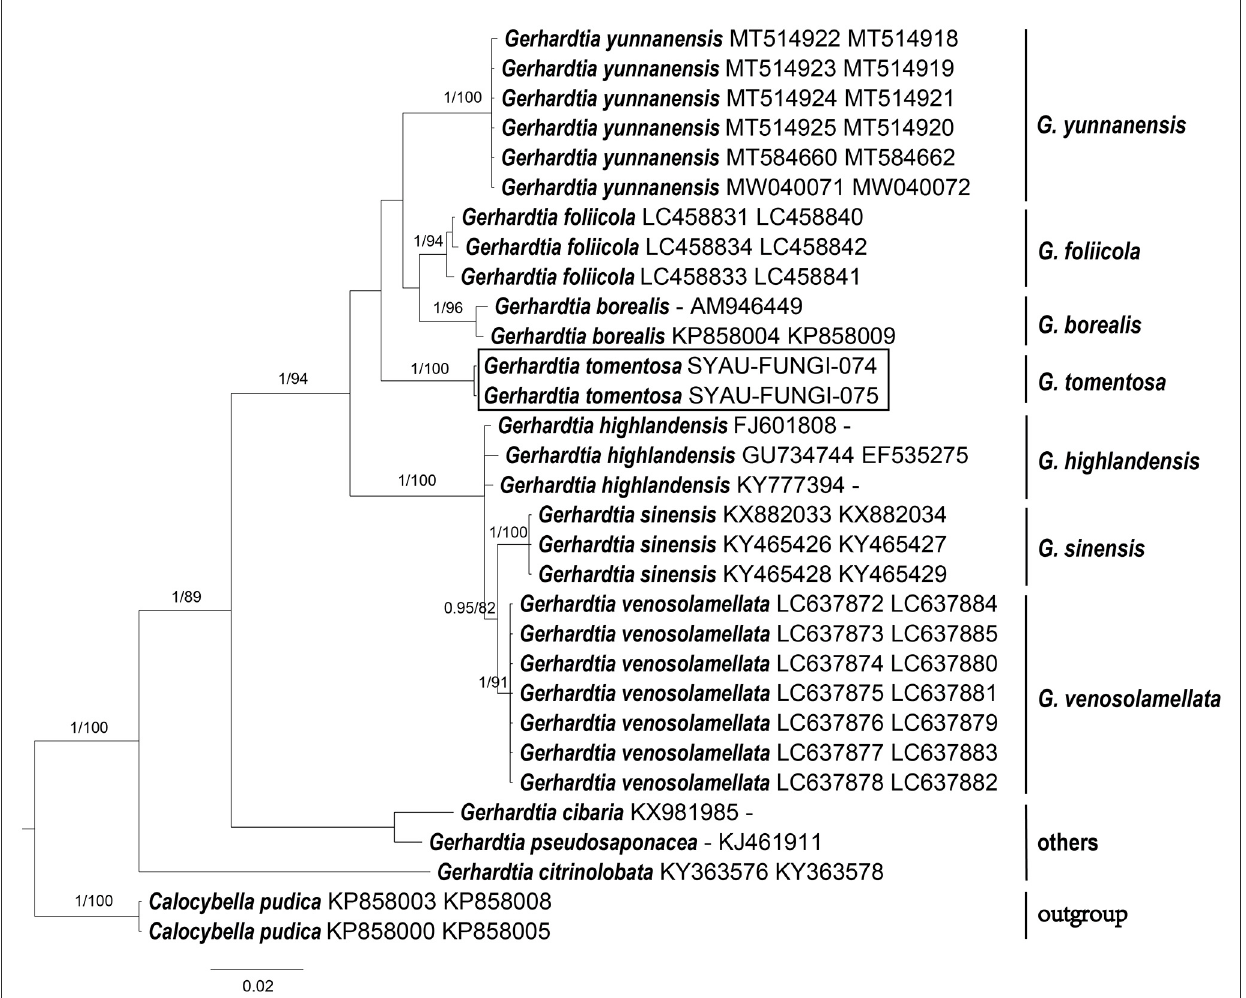
FIGURE2 ML and BI analysis of Gerhardtia based on ITS and nrLSU sequences. PP ≥ 0.95 (left) and BS ≥ 60 (right) are indicated on branches. Calocybella pudica is rooted as the out-group. Newly generated sequences for Gerhardtia tomentosa are highlighted in boxes. GenBank accession numbers are provided after the species